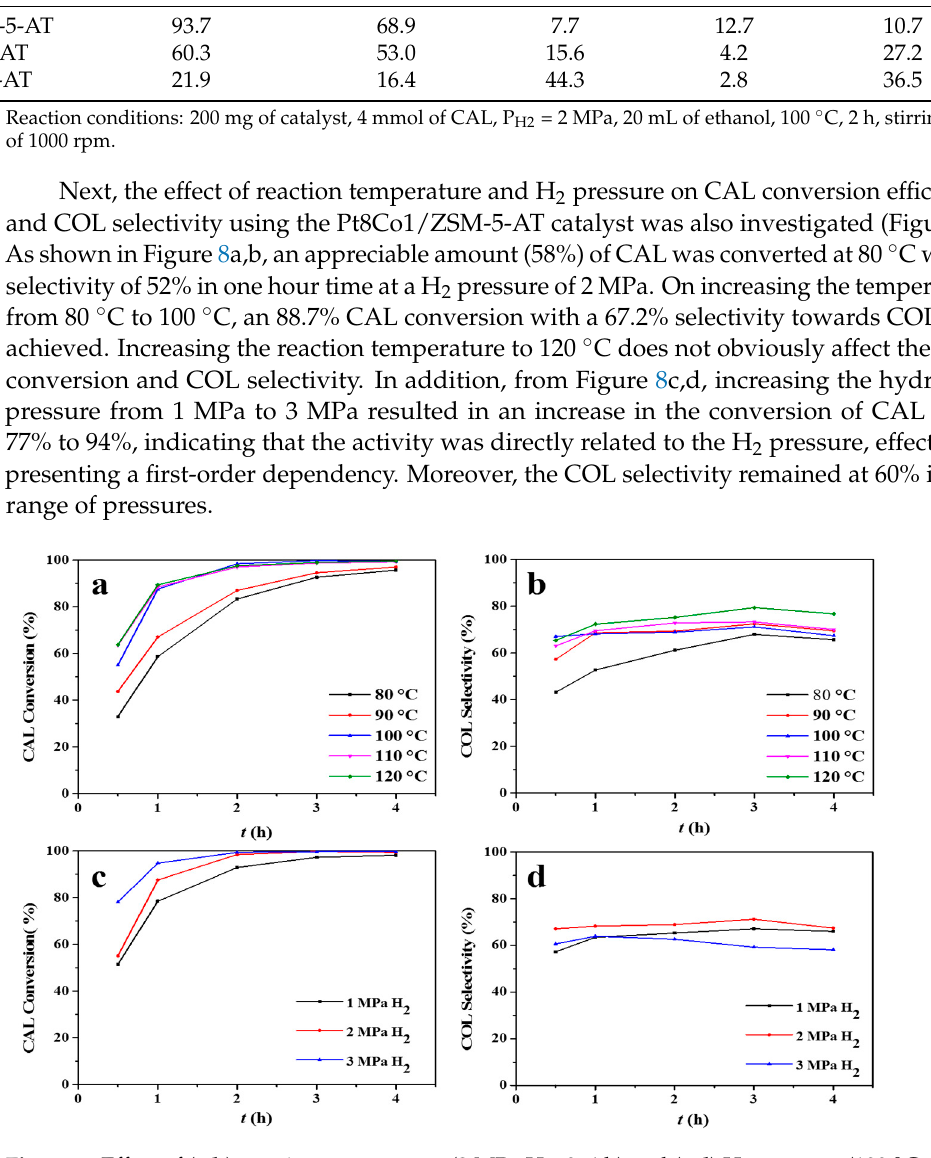
Figure 8. Effect of ( a , b ) reaction temperature (2 MPa H 2 , 0-4 h) and ( c , d ) H 2 pressure (100 °C, 0–4 h) on CAL conversion efficiency and COL selectivity over the Pt8Co1/ZSM-5-AT catalyst. Reaction